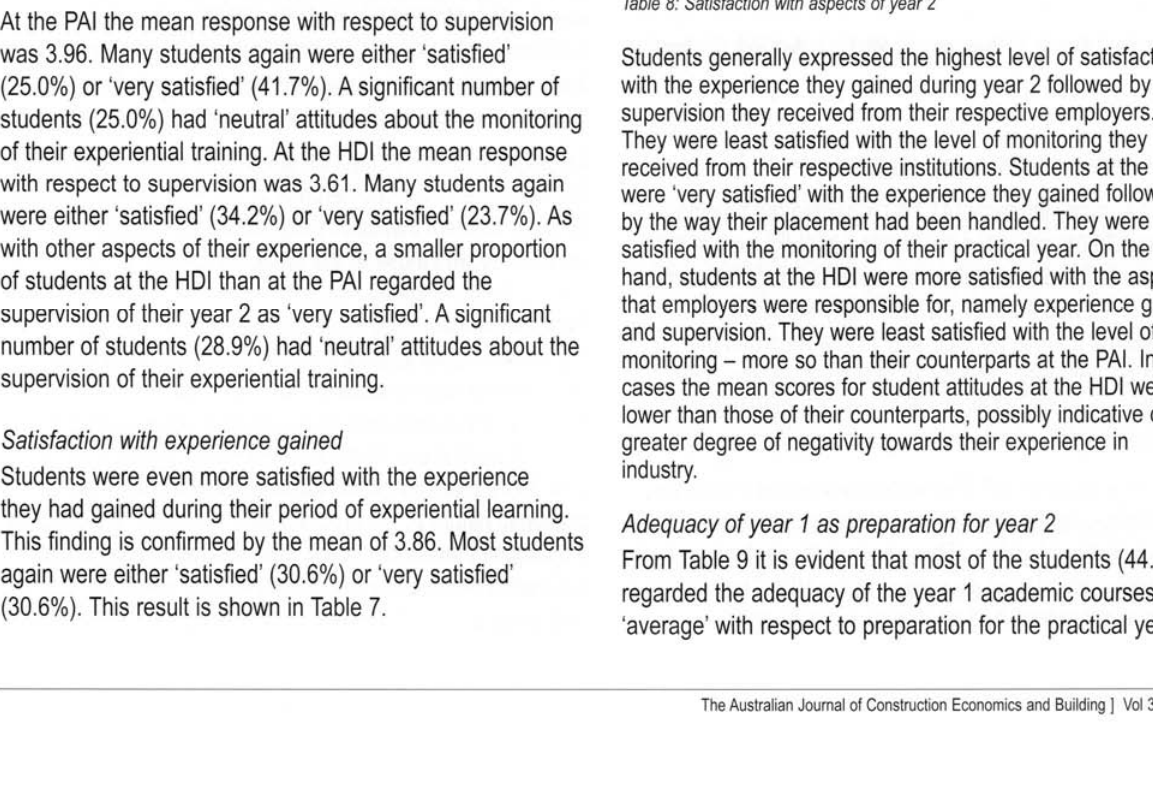
Table 8: Satisfaction with aspects of year